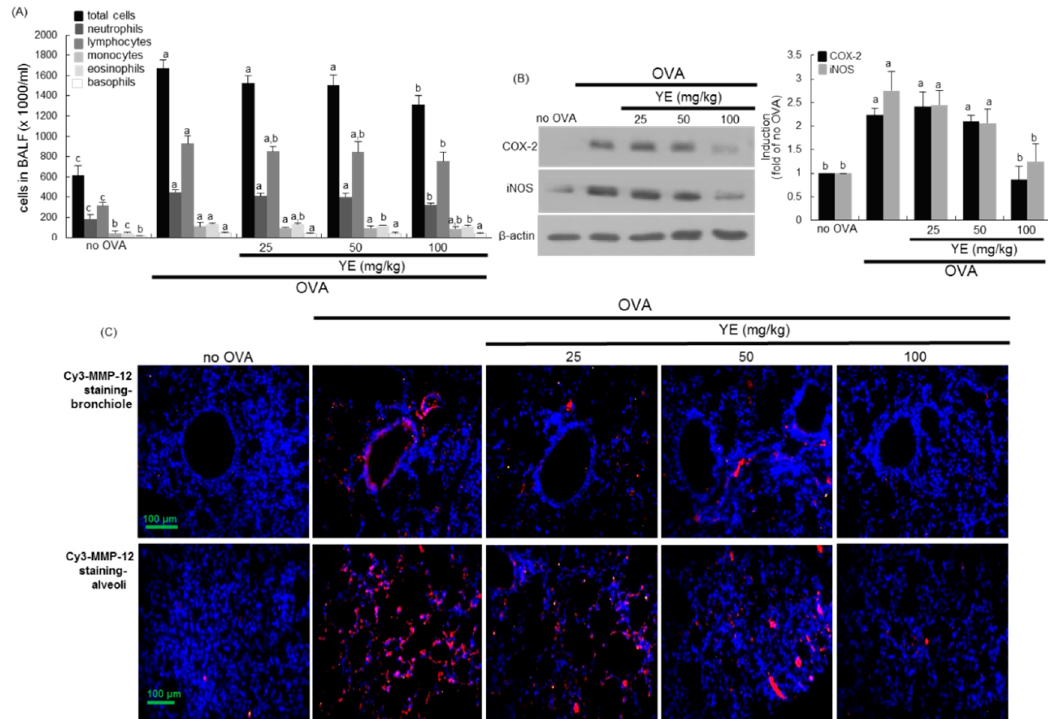
Figure 6. Suppressive effects of dried yeast extract (YE) on airway inflammation and induction of airway target proteins in ovalbumin (OVA) inhalation-challenged mouse lungs. OVA-sensitized mice were orally administrated with 25–100 mg/kg YE. Cells in BALF were counted using a Hemavet HV950 Multispecies Hematologic Analyzer ( A ). Lung tissue extracts were subject to Western blot with a primary antibody against COX-2 and iNOS ( B ). β -Actin protein was used as an internal control. The bar graphs (mean ± SEM, n = 3) represent quantitative results of the left bands obtained from a densitometer. Values in respective bar graphs not sharing a same small letter indicate a significant difference at p < 0.05 Immunohistofluorescence analysis was done in tissues of small airways and alveoli of OA-challenged mice ( C ). The MMP-12 localization was identified as Cy3-red staining in mouse airways exposed to OVA. Nuclear staining was done with DAPI (blue). Each photograph is representative of four mice. Scale bars = 100 µm.